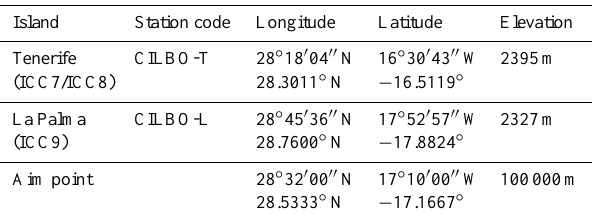
Fig. 3. Technical drawing of the camera showing the main elements.